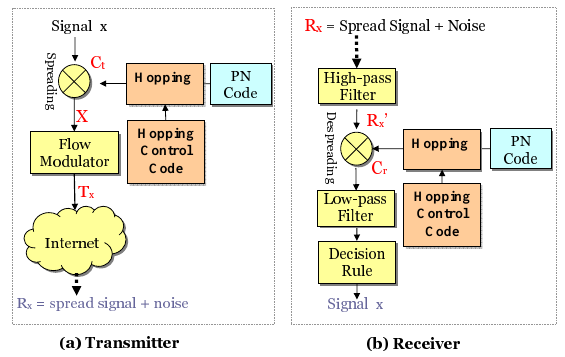
Figure 4: A Framework of Hopping-Based Spread Spectrum for Network Forensic